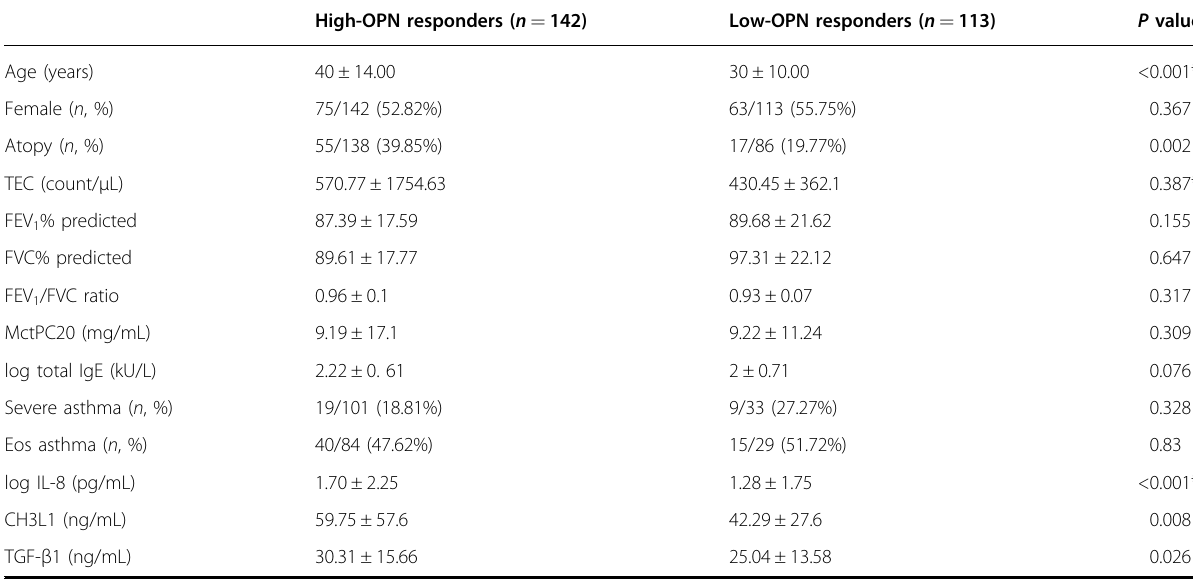
Table 2 Comparison of demographic characteristics between high-OPN and low-OPN